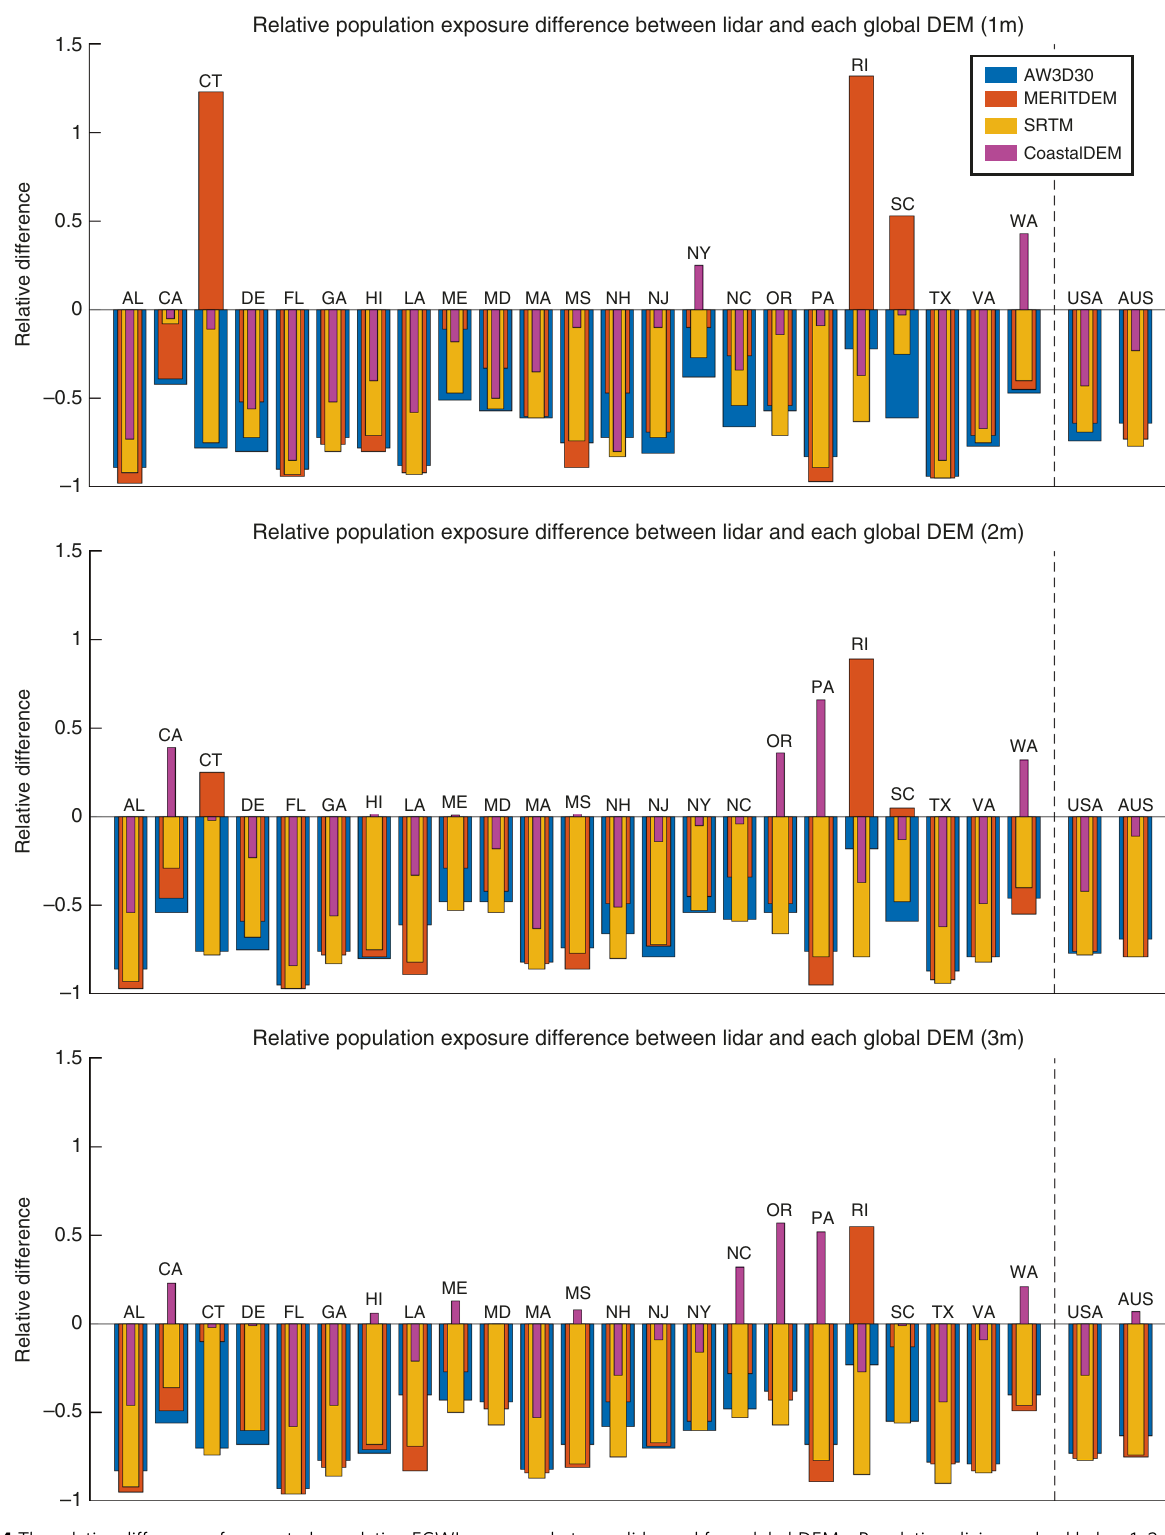
Fig. 4 The relative difference of computed population ECWL exposure between lidar and four global DEMs. Populations living on land below 1, 2, and 3 m are computed in the US and Australia with each DEM. Zero relative differences indicate both lidar and the given global DEM predict the same number of people below the elevation threshold whereas, for example, − 0.5 and 0.5 would indicate that the global DEM underestimation or overestimated by 50%, respectively. Results are given for each US state, as well as at the national scale in the US and Australia. Source data are provided as a Source Data fi